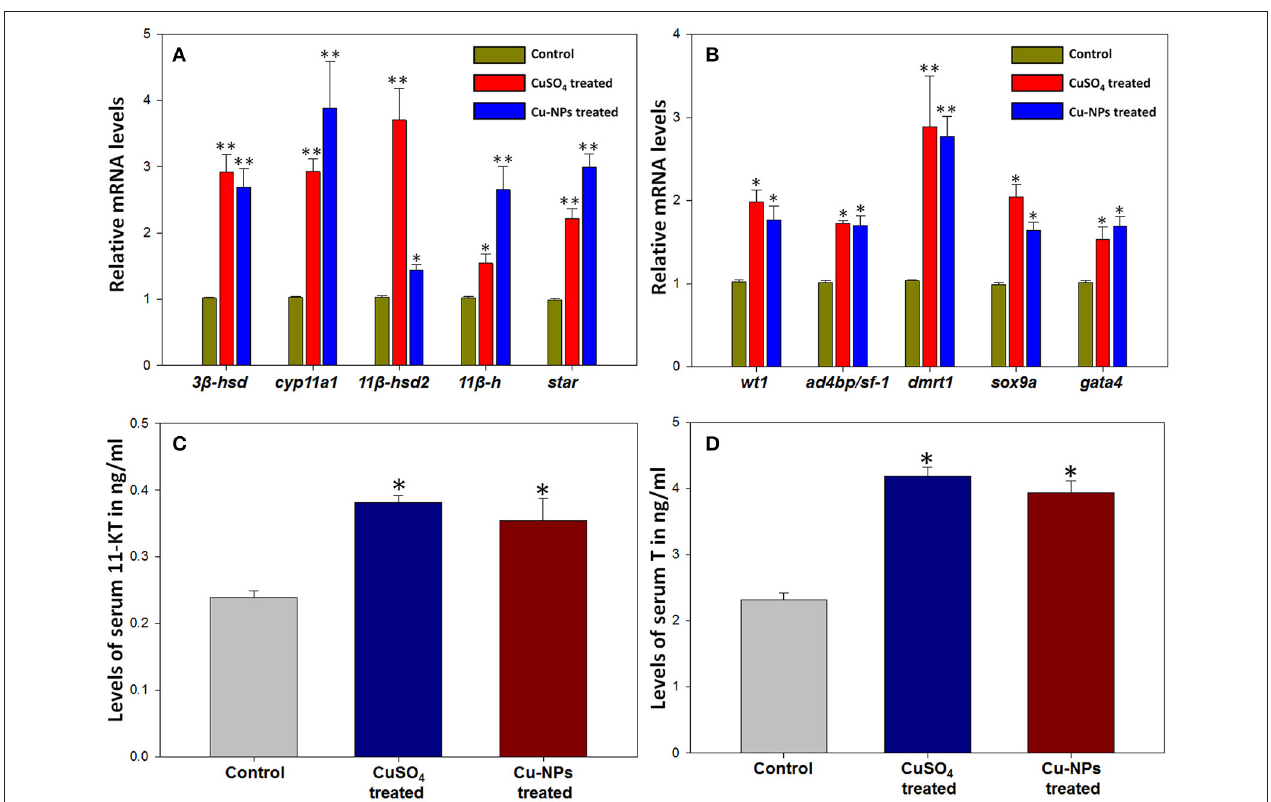
FIGURE 2 | Changes in mRNA transcripts of several steroidogenic enzyme (A) and transcription factor (B) genes and levels of androgens, 11-ketotestosterone (C) and testosterone (D) after Cu/Cu-NPs exposure during testicular recrudescence in catfish, C. batrachus . Data ( n = 5) were expressed as mean ± SEM (*, P < 0.05; ** P < 0.01; ANOVA followed by Student-Newman-Keuls’ post-hoc